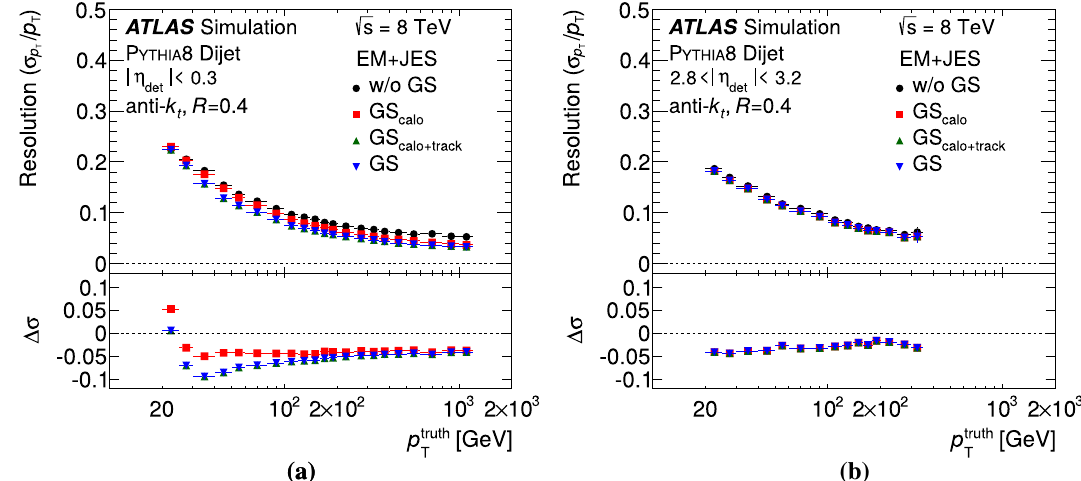
Fig. 10 Jet p T resolutionasafunctionof p truth squares), with calorimeter- and track-based corrections only (green inthenominal Pythia8 T upward triangles) and including all the global sequential corrections MC sample for jets with a | η det | < 0 . 3 and b 2 . 8 < | η det | < 3 . 2. The (blue downward triangles). The lower panels show the improvement jets are reconstructed with anti- k t R = 0 . 4. Curves are shown after the relative to the EM+JES scale without global sequential corrections EM+JES calibration without global sequential corrections (black cir- obtained using subtraction in quadrature (Eq. (9)) cles), with calorimeter-based global sequential corrections only (red